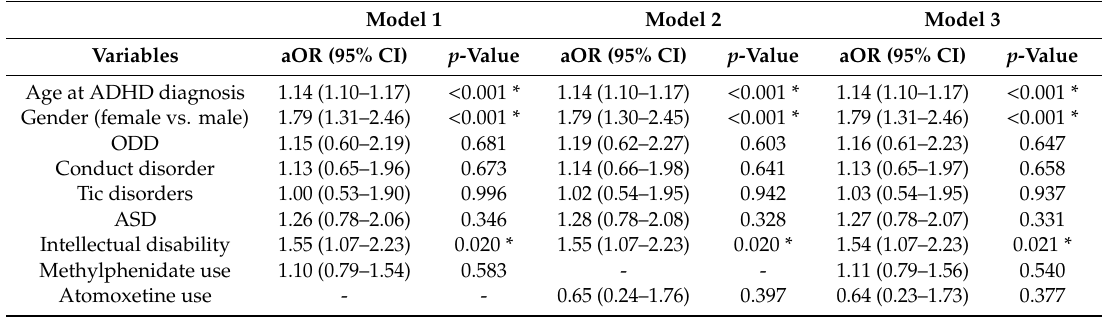
Table 3. Relationships of pharmacotherapy and diagnoses of adrenal gland dysfunction among patients with ADHD, controlling for sex, age, and psychiatric comorbidities.